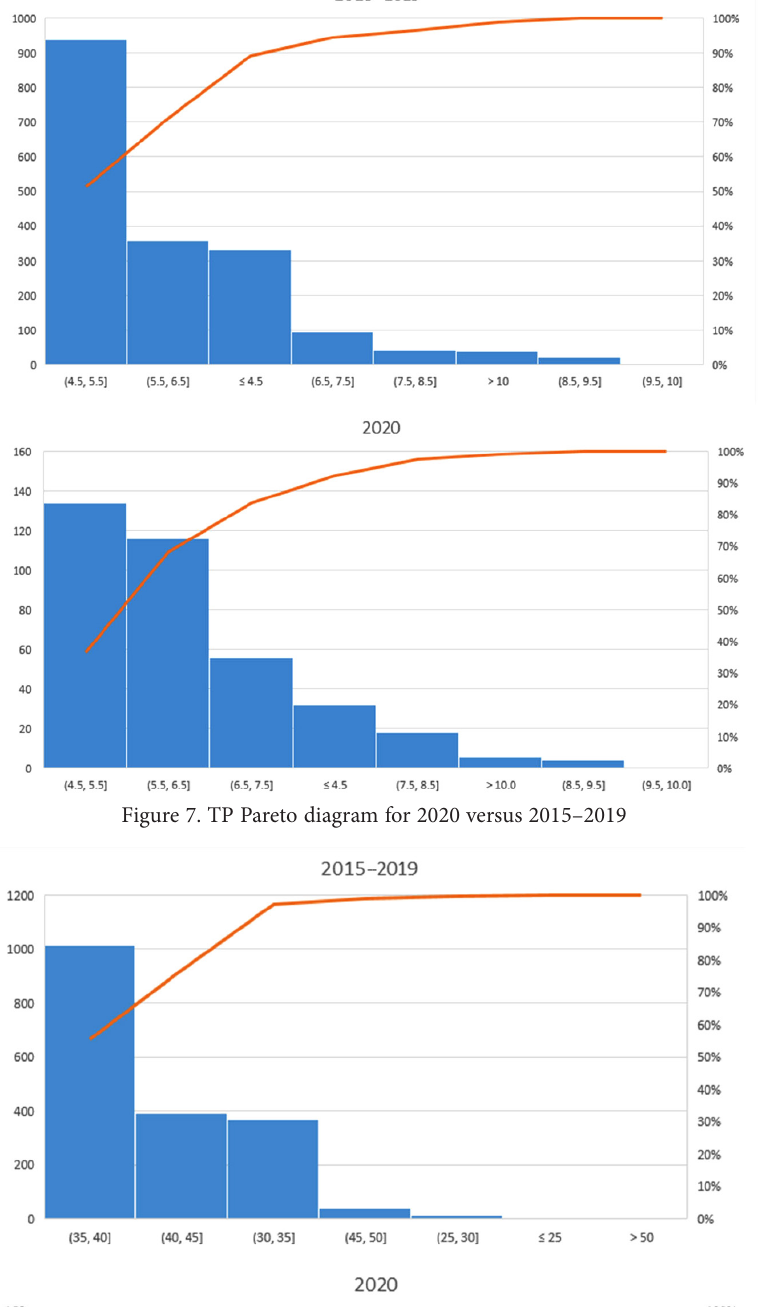
Figure 8. TKN Pareto diagram for 2020 versus